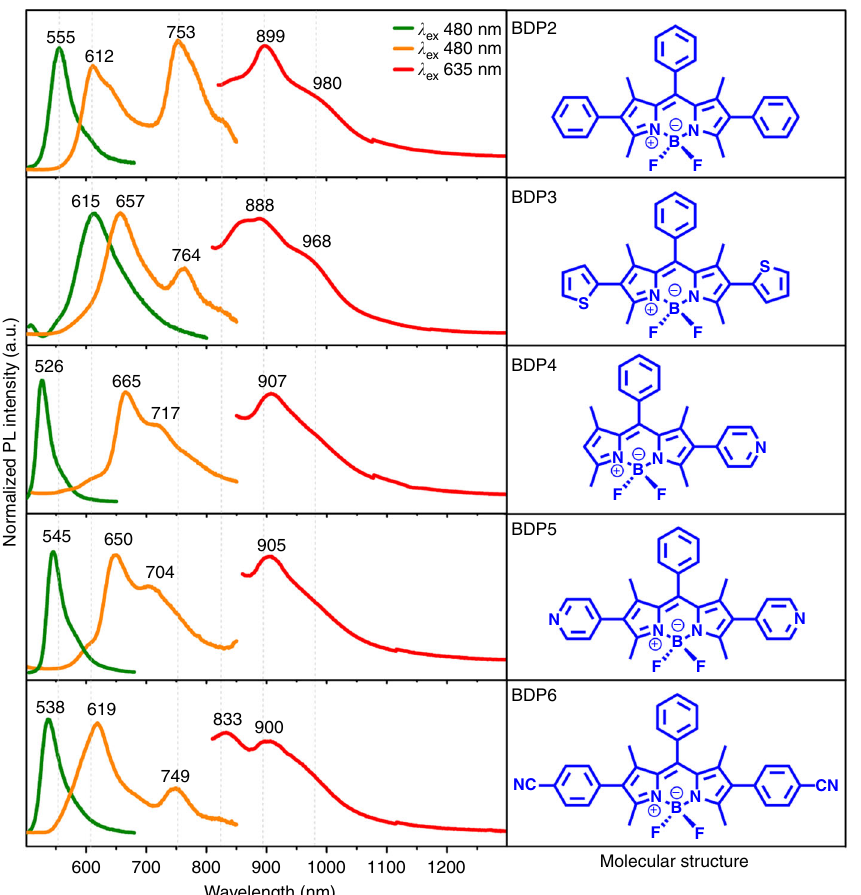
Fig. 6 Photophysical properties of microcrystalline state BDP2 to BDP6. Normalized fl uorescence emissions (left column) of BDP2 to BDP6 in solution (green lines) and microcrystalline powder state (orange and red lines) with corresponding molecular structures in the right manipulation of multiple energy levels of solid-state organic luminophors toward a greatly widened scope of applications.